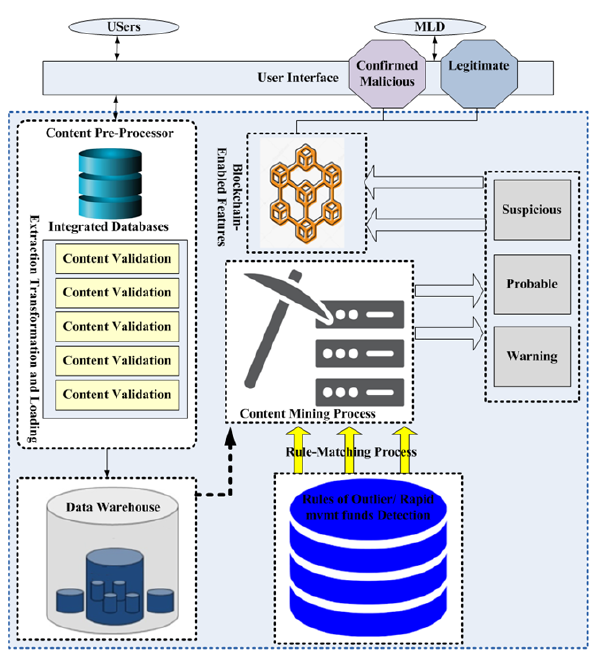
Figure 5. Blockchain-enabled transaction scanning